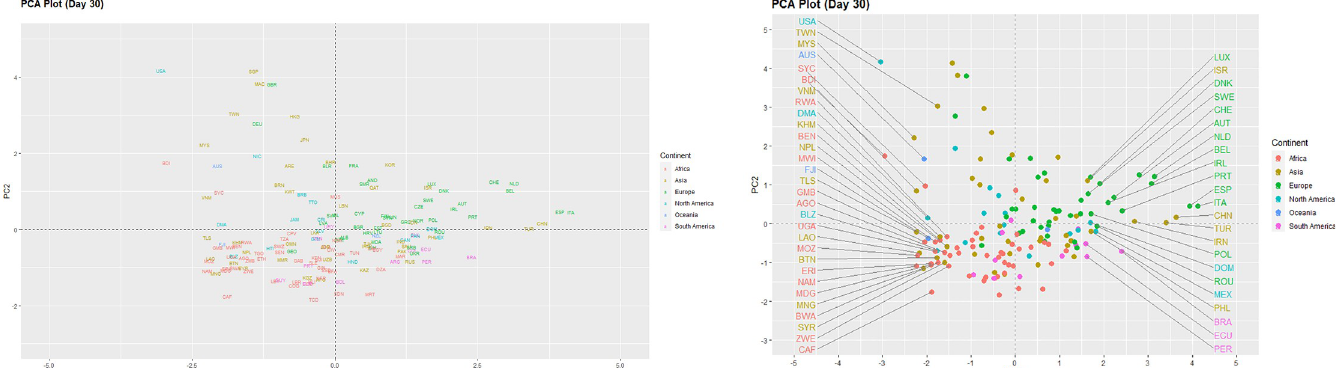
Fig 1. PCA plot (Day 30).